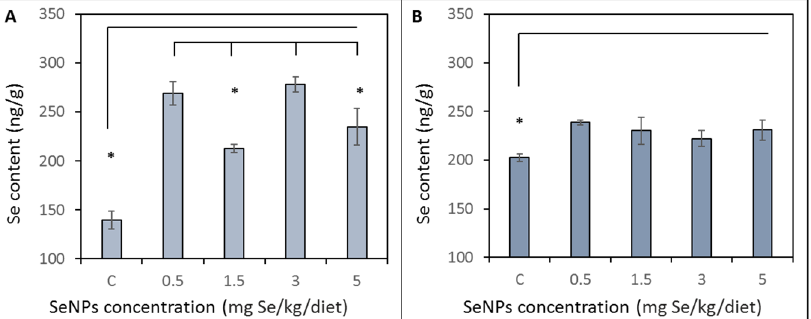
Figure 2. Selenium content obtained by AAS in ( A ) blood and ( B ) liver tissue. Rats were fed on a monodiet containing wheat and the different dose of selenium nanoparticles (0.5, 1.5, 3 and 5 mg Se/kg). Results are compared with the control group (C) of rats fed on a monodiet containing 0.03 mg Se/kg. * Mean values were significantly different ( p < 0.05). Details of measurement are described in the Materials and Method section.